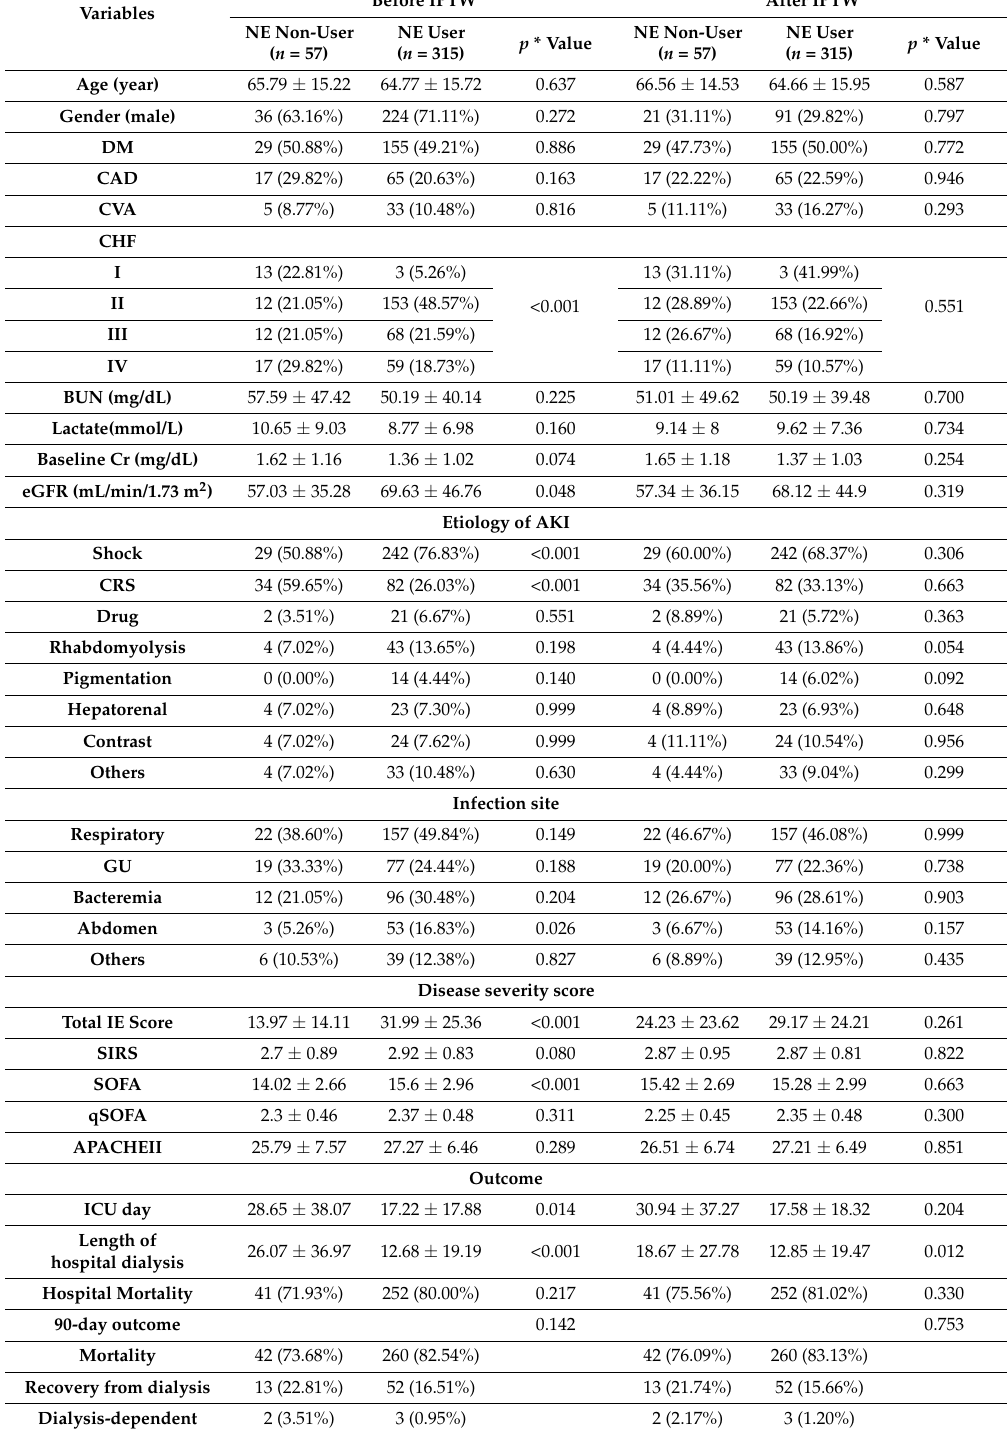
Table 1. Comparison of baseline characteristic and outcomes of septic shock patients with norepinephrine (NE) or other vasoactive agents at dialysis